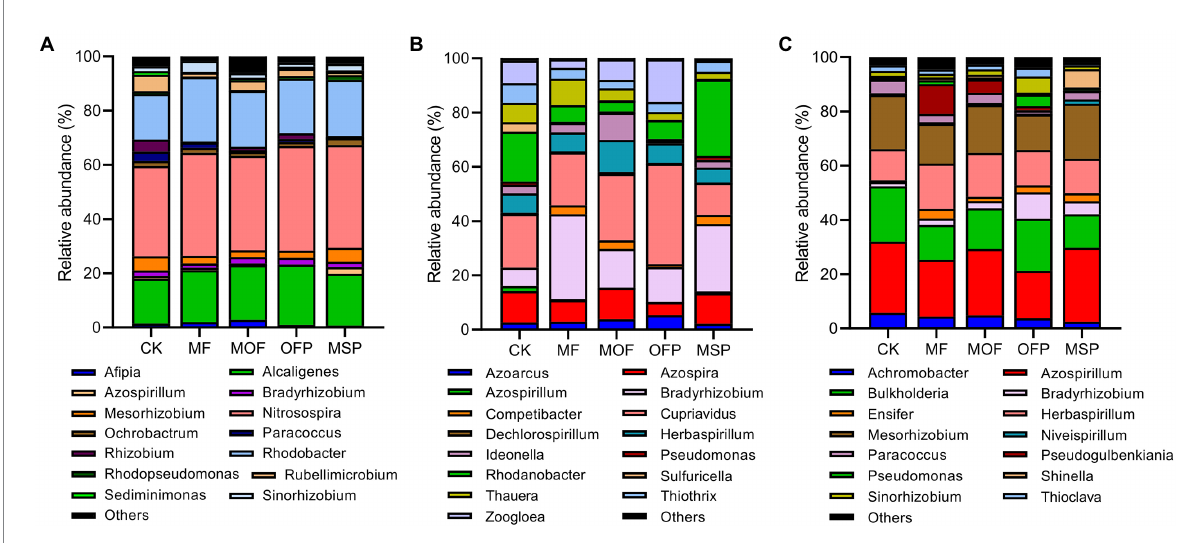
FIGURE 4 Taxonomic compositions of nirK - (A) , nirS - (B) , and nosZ -harboring (C) denitrifiers at the genus level under different fertilization treatments. CK, No fertilization; MF, mineral fertilizer; MOF, mineral fertilizer plus commercial organic fertilizer; OFP, commercial organic fertilizer; MSP, maize straw.